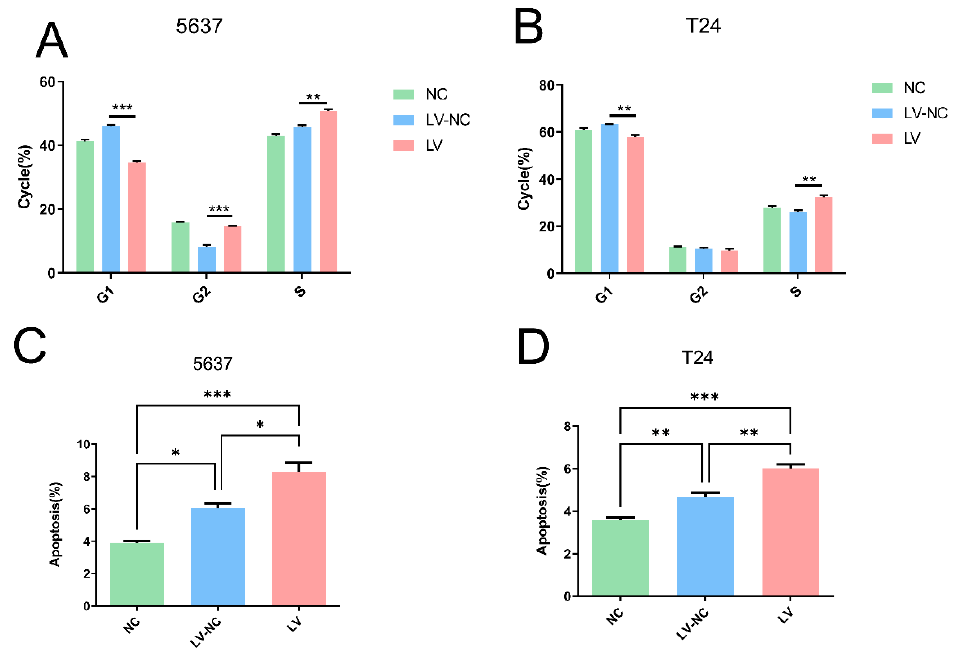
Figure 6. The cell cycle and apoptosis assays detected by flow cytometry in three groups (transfec- tion group, LV; negative control group, LV-NC; blank group, NC). ( A ) Cell cycle of 5637 cells. ( B ) Cell cycle of T24 cells. ( C ) Cell apoptosis of 5637 cells. ( D ) Cell apoptosis of T24 cells. * indicates p -value < 0.05, ** indicates p -value < 0.01, *** indicates p -value < 0.001.